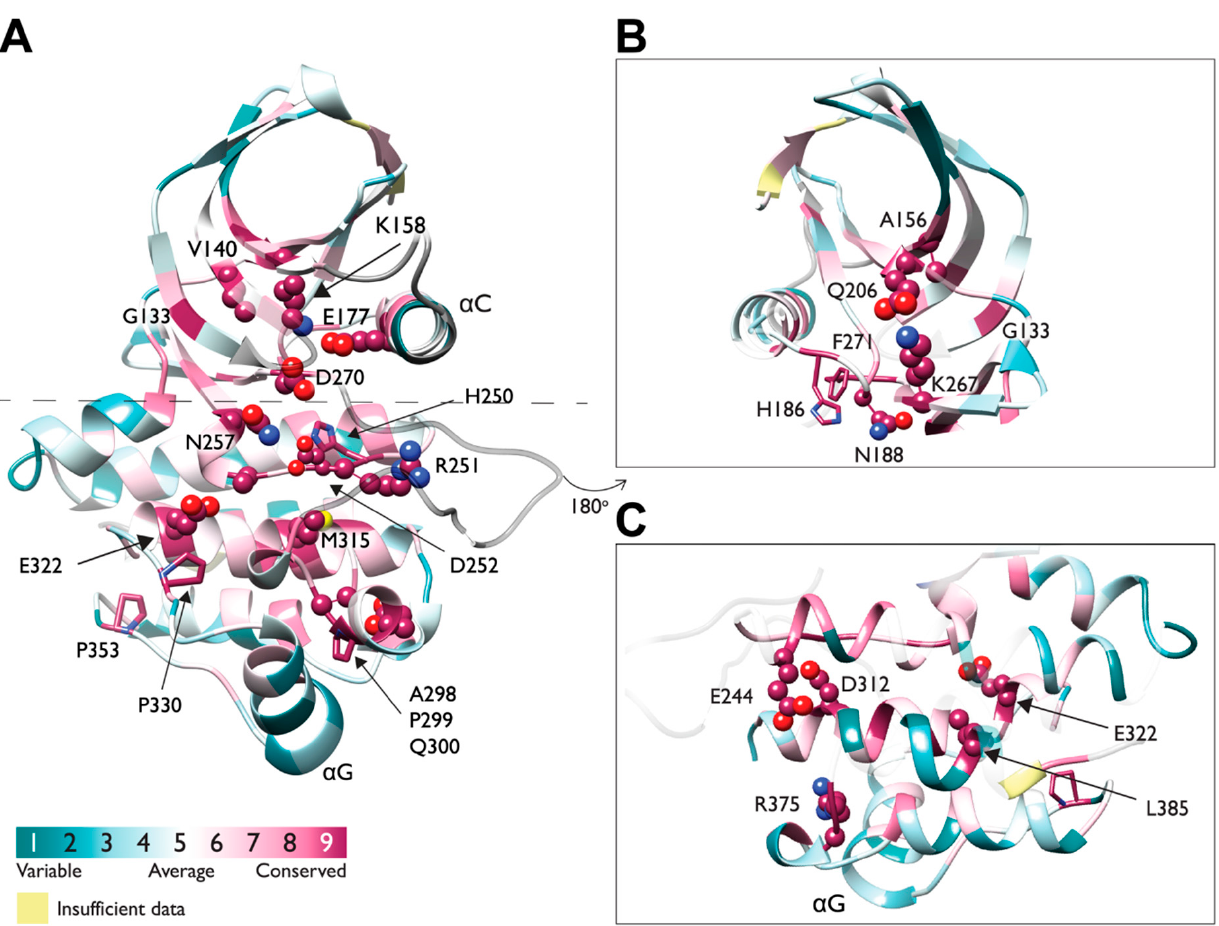
Figure 9. A 3D representation of evolutionarily conserved residues in Ack1 KD. ( A ) Sequence conservation of Ack1 KD presented as a cartoon diagram from two viewpoints (panel ( A ) rotated by 180 ◦ as panels ( B , C )) and determined using the ConSurf server [96–101] using the crystal structure of active Ack1 (PDB: 4EWH) as the input. ConSurf assigns each residue with a normalized score of 1 to 9, where 1 indicates the least conserved (highly evolving) sites, and 9 corresponds to the most evolutionarily conserved positions. The conservation scores were mapped onto the Ack1 KD structure (PDB 4EWH) using ConSurf color code, with a cyan-to-maroon gradient corresponding to the variable (1) to conserved (9) positions. The panels depict conserved residues (with a score of 8 or 9) in the space-filling model. ( B ) The N-lobe rotated by 180° from panel ( A ). ( C ) The C-lobe rotated by 180° from panel ( A ).